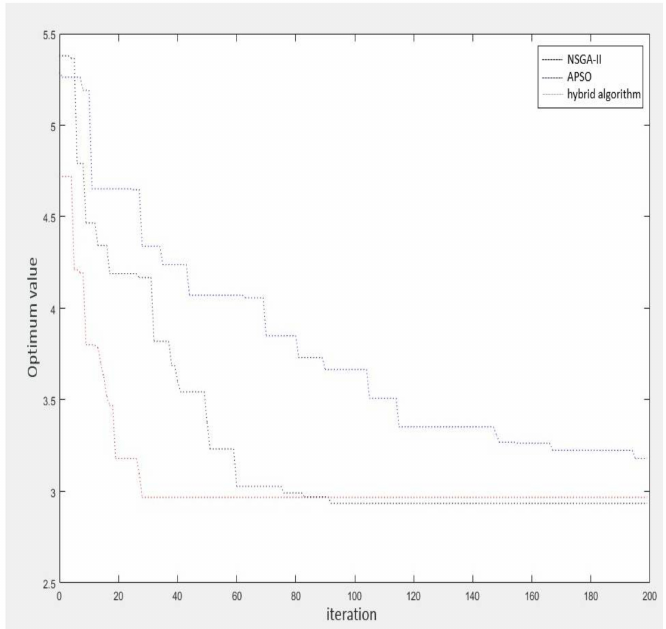
Figure 8. Comparison with classical traditional algorithms for optimizing F2.